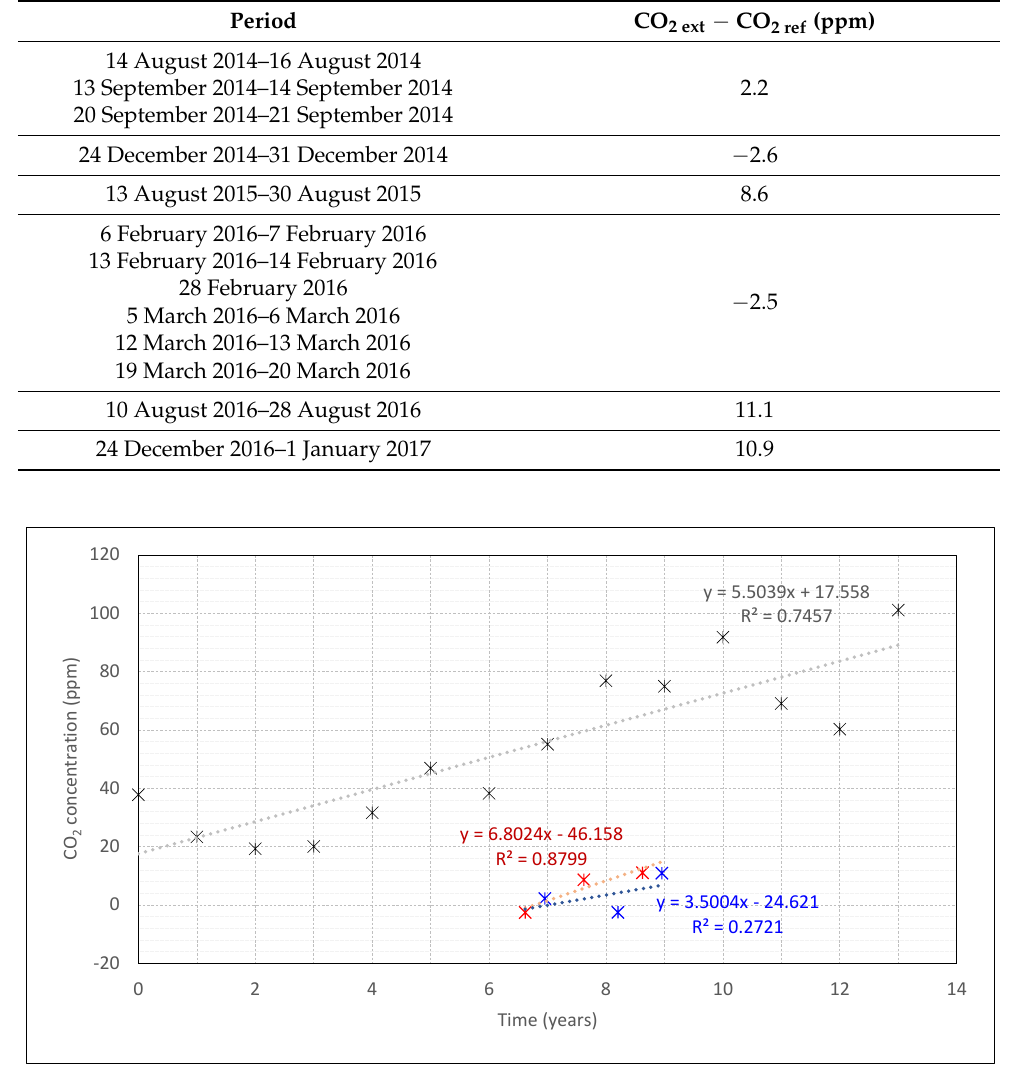
Figure 3. Difference in daily mean values of the CO 2 concentration between Ext and R01 Ref sensors during unoccupied periods of summer (red) and winter (blue), and spread of the measurements (grey) obtained as the standard deviation of the mean daily mean values of the CO 2 concentration between R13, R01, R02, R12, R13, R14, SR, CR13, CR19 and R01 Ref CO 2 sensors during unoccupied periods in August. The 0 in the x -axis corresponds to the year 2008.